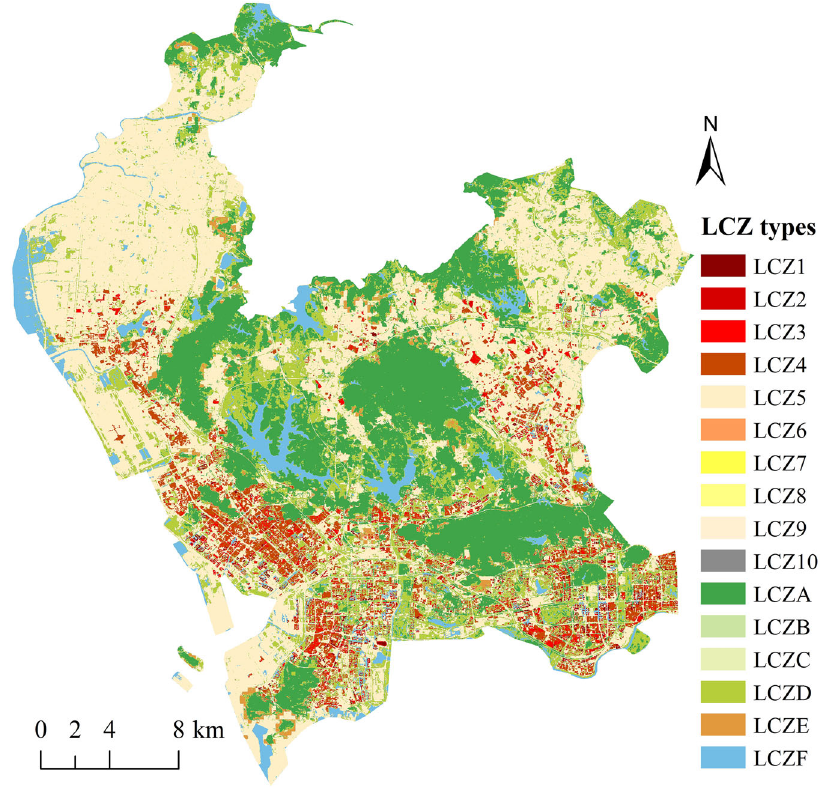
Fig. 2 LCZ spatial distribution. LCZ1-10 and LCZA-F respectively represent different LCZ